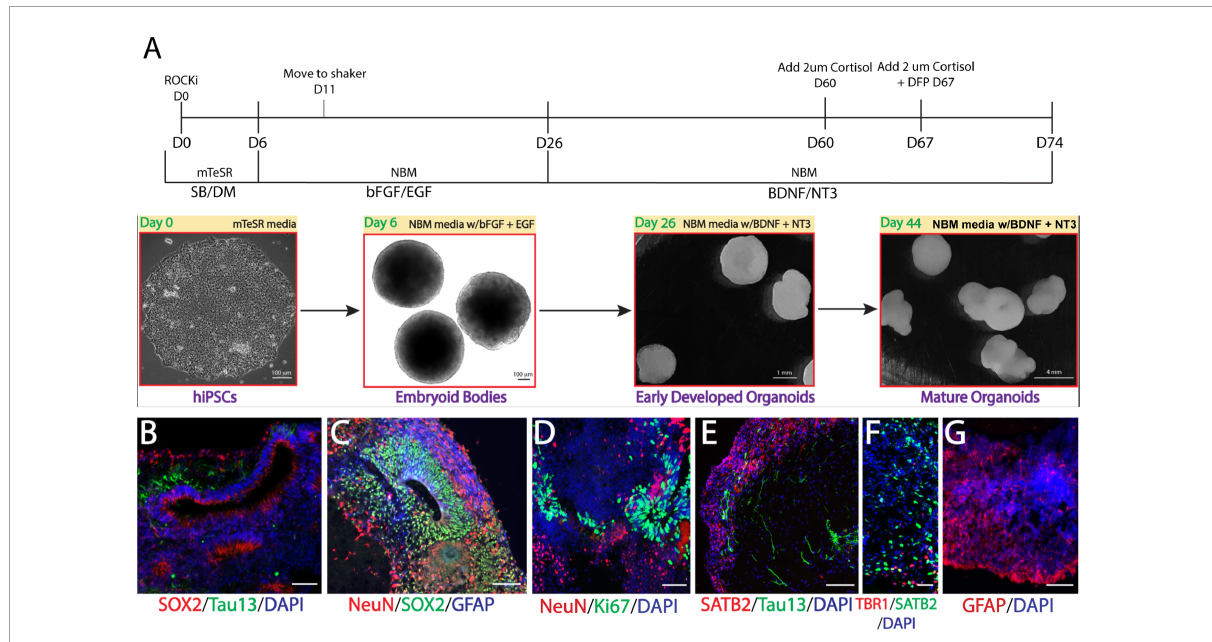
FIGURE1 Generation of Gulf War (GW) veteran-derived forebrain cerebral organoids. (A) Schematic of the procedure used to generate forebrain cerebral organoids [Dorsomorphin (DM), SB-4321542 ( SB ) , basic fibroblast growth factor (bFGF), epidermal growth factor (EGF), brain-derived neurotrophic factor (BDNF), neurotrophin 3 (NT3), Neurobasal Differentiation Media (NBM)]. (B–D) Immunofluorescence images of forebrain cerebral organoids stained for the proliferative markers Sox2 and Ki67, neuronal markers tau and NeuN, the astrocytic marker glial fibrillary acidic protein (GFAP), and 4, 6-diamino-2-phenylindol (DAPI) nuclei. (E, F) Images stained for the cortical layer markers SATB2, Tbr1, tau, and DAPI. (G) Image shows astrocyte GFAP staining. Scale bars (B–G) , 50 µ